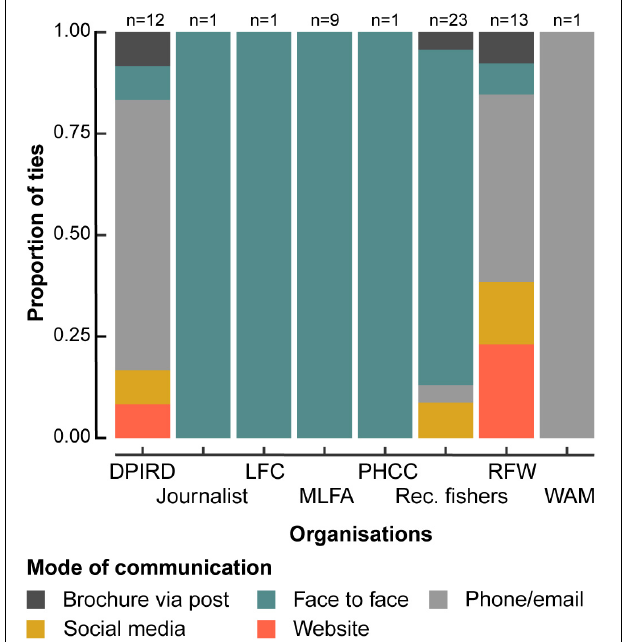
FIGURE 5 | The proportion of information exchanges between recreational fishers and organizations involving various modes of communication, as reported by recreational fishers. Sample sizes ( n ) on which these proportions are estimated are also presented. Refer to Table 1 for information on which acronym corresponds to each